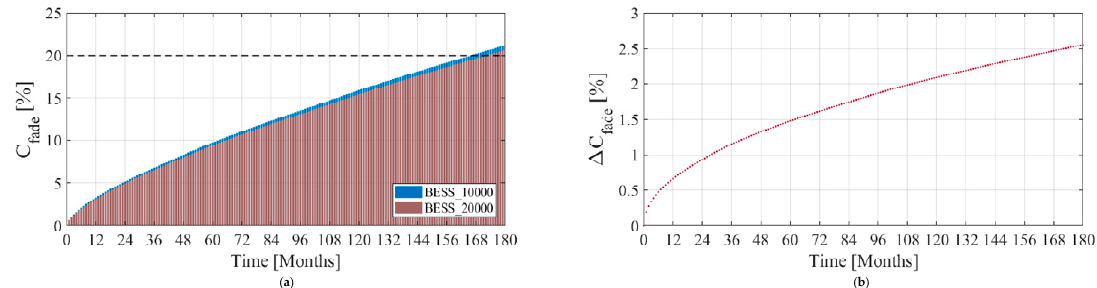
Figure 10. ( a ) Capacity fade for reduced interval of BESS sizes, ( b ) Relative difference of capacity fade with the referent capacity of BESS_20000.